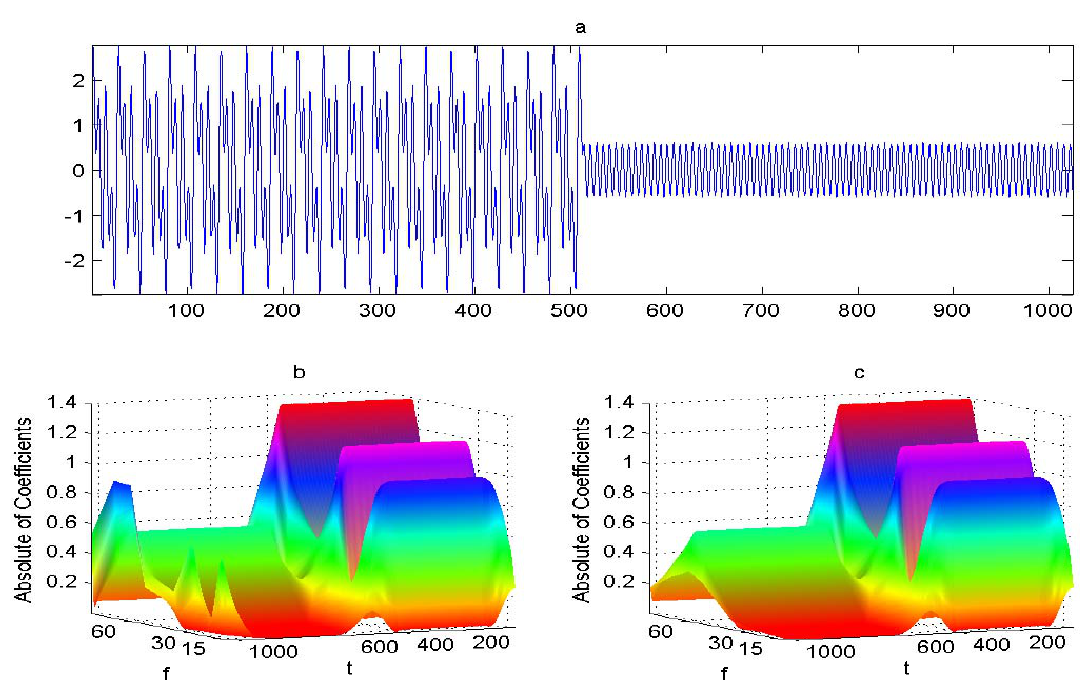
Figure 1. ( a ) is Data 1 with N = 1024. ( b ) the absolute values of CWT coefficients of ( a ), computed with the awt function in Wavelab, where the shape parameter σ 2 = 1 and the center frequency η = 8, manifests edge effects. ( c ) without edge effects is computed with Algorithm